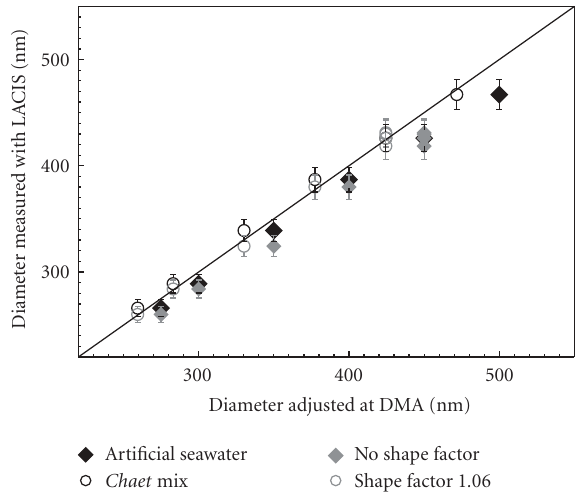
Figure 2: Comparison of dry particle diameters as selected by the DMA with the respective values measured with LACIS. The black line is the 1-to-1